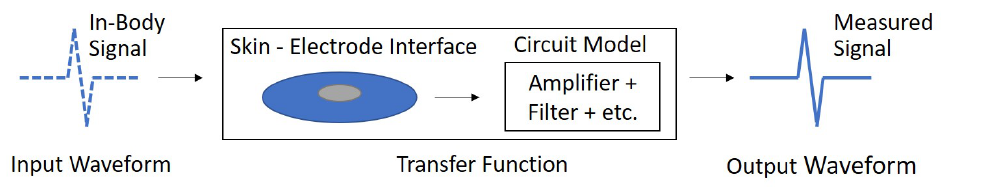
Figure 3. Notional Block Diagram of the ECG